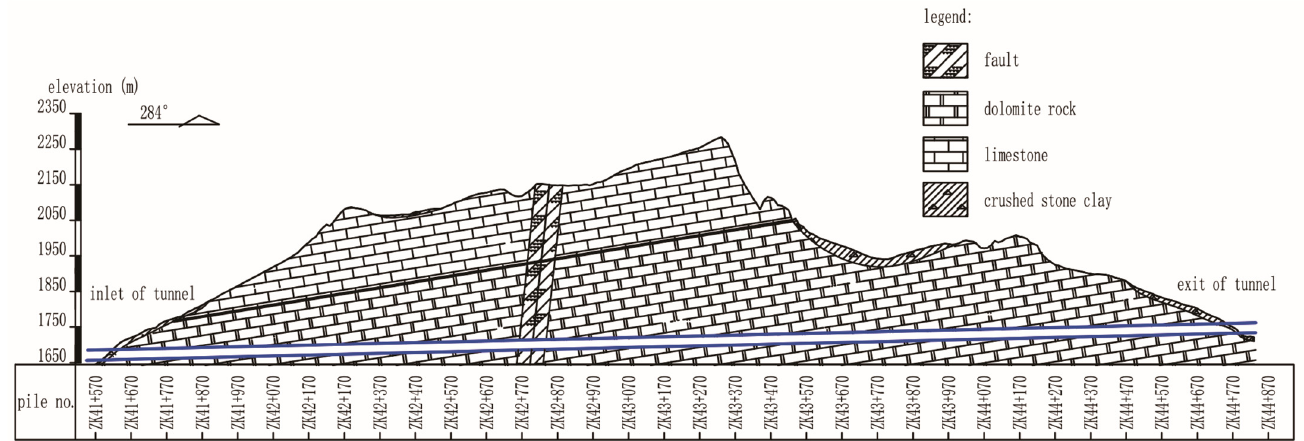
Figure 2. Geological profile along the tunnel.